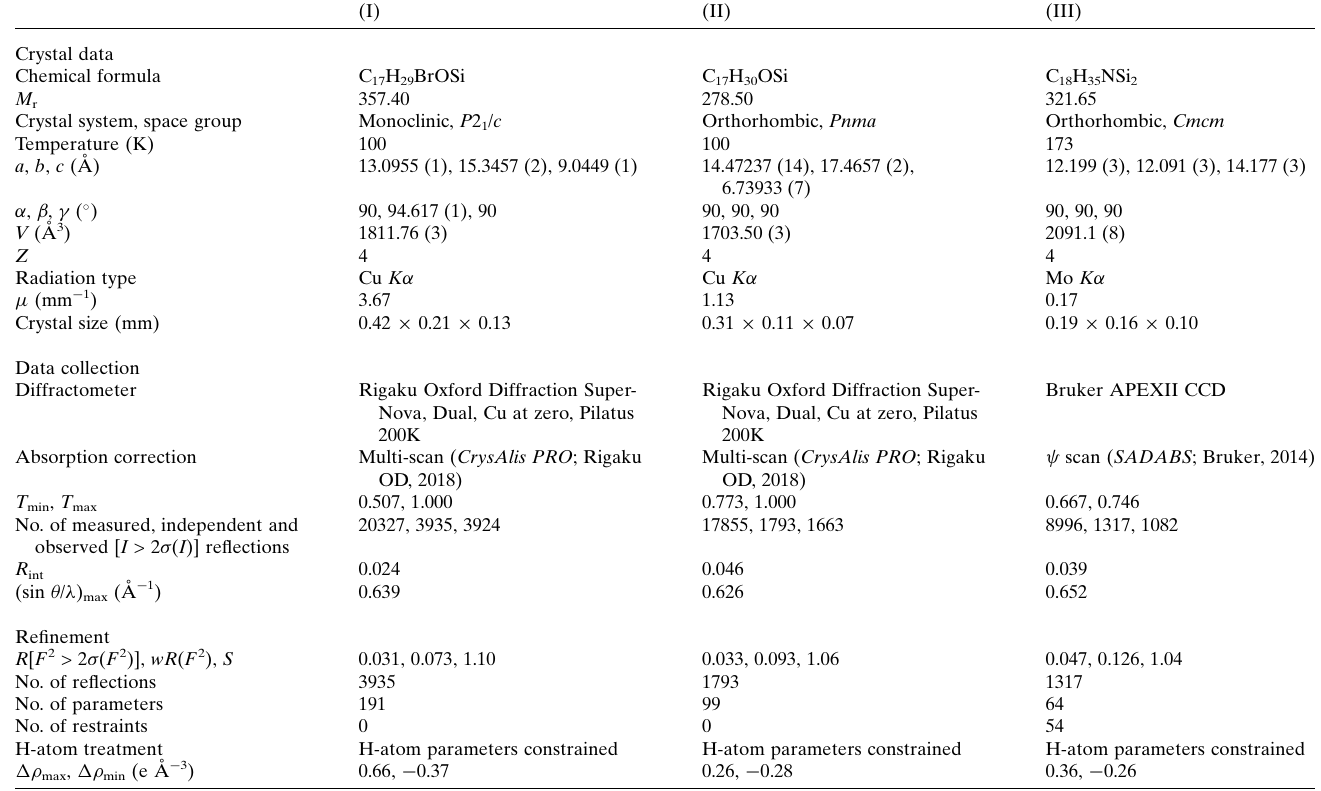
Table 2 Experimental details.